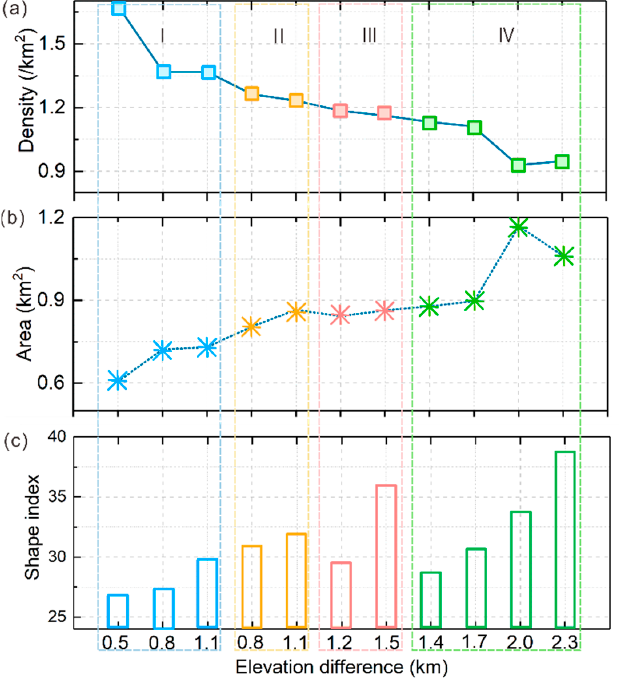
Figure 12. Statistical result of spatial distribution characteristics for the SUs. ( a – c ) is the average density, average area and shape index of the SUs in in I, II, III and IV topographic patterns, respectively. In addition, the shapes of SUs were also sensitive to various topographic